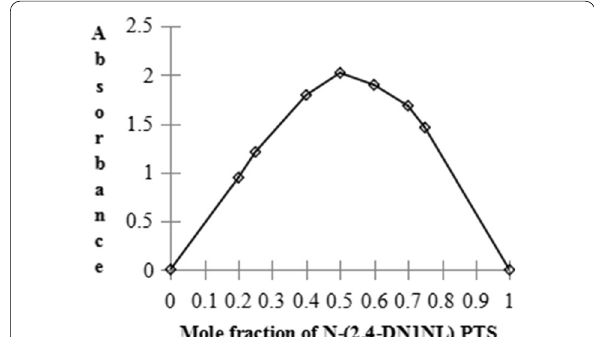
Fig. 3 Job’s plot of charge transfer complex of N-(2,4-DN1NL) PTS with CFR